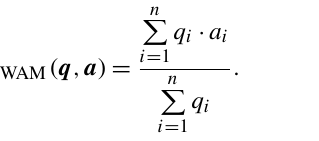
Figure 4. Development of the dynamic reliability r d emplary sensor S i with ω = { 0 . 01 , 0 . 1 , 0 . 5 } . At the beginning of the pictured period the measured value of the sensor drastically changes and is in conflict with other